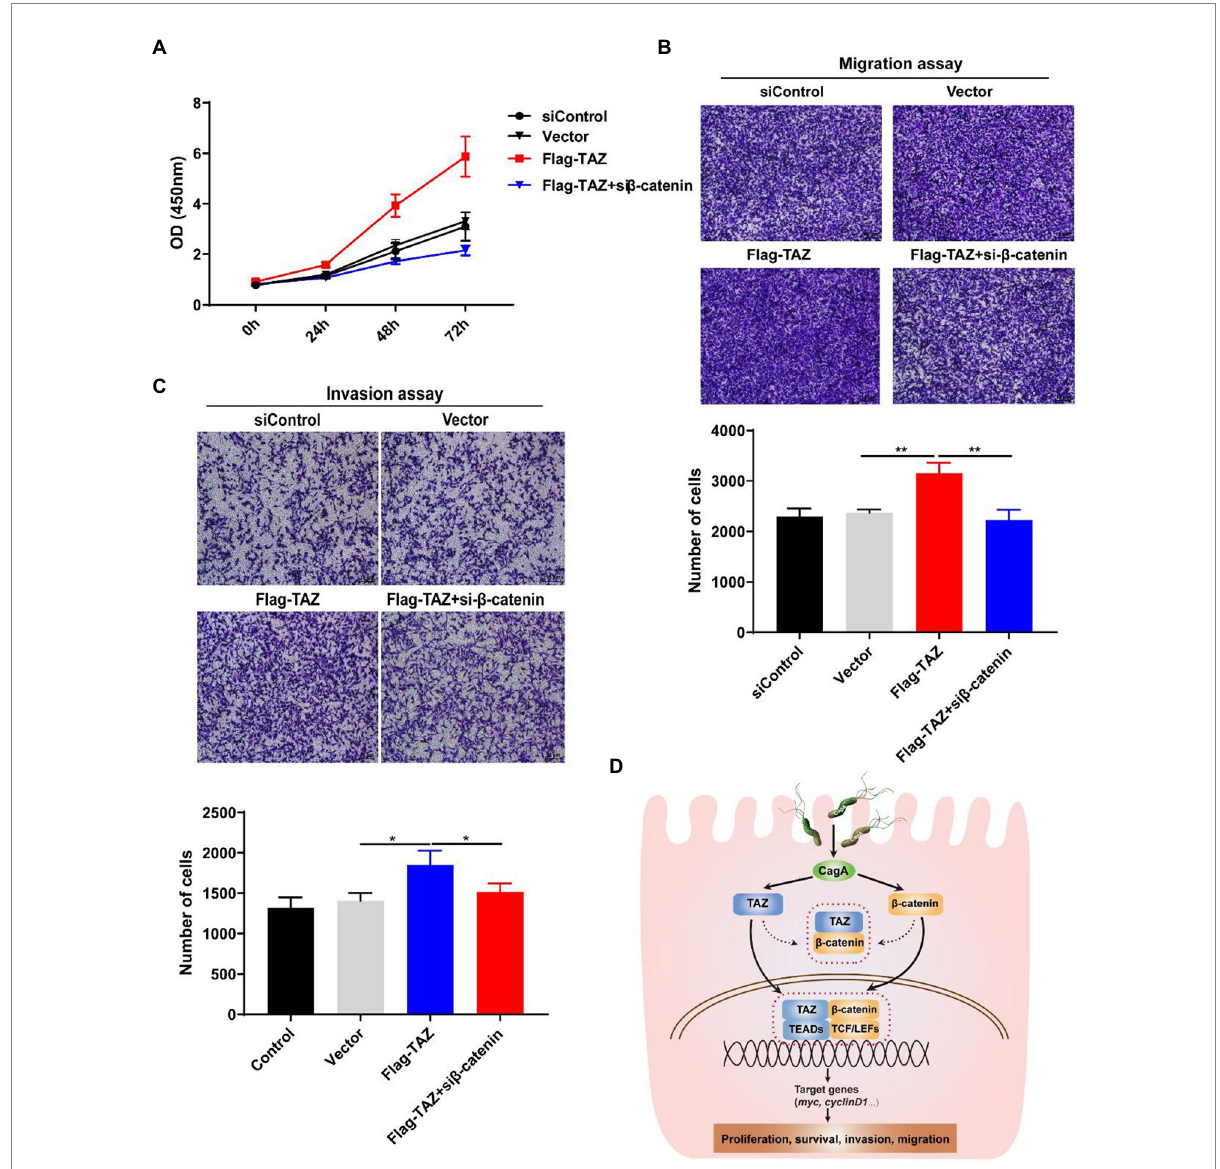
FIGURE 7 Knockdown of β -catenin significantly suppressed TAZ-induced cell proliferation, invasion, and migration. (A) CCK8 assay for cell proliferation in AGS cells treated as described for A . (B,C) Transwell assays for migration (B) and invasive (C) ability of AGS cells treated as described above. (Magnification 100×, scale bars =10 μ m). (D) Schematic representation of the regulation of the TAZ/ β -catenin axis by H. pylori infection in gastric